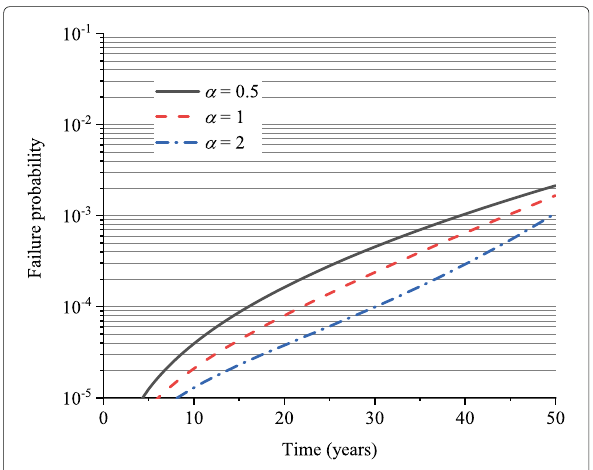
Fig. 8 Dependence of failure probability of a weighted 4-out-of-5 system on deterioration shape with g ( 50 ) = 0.8